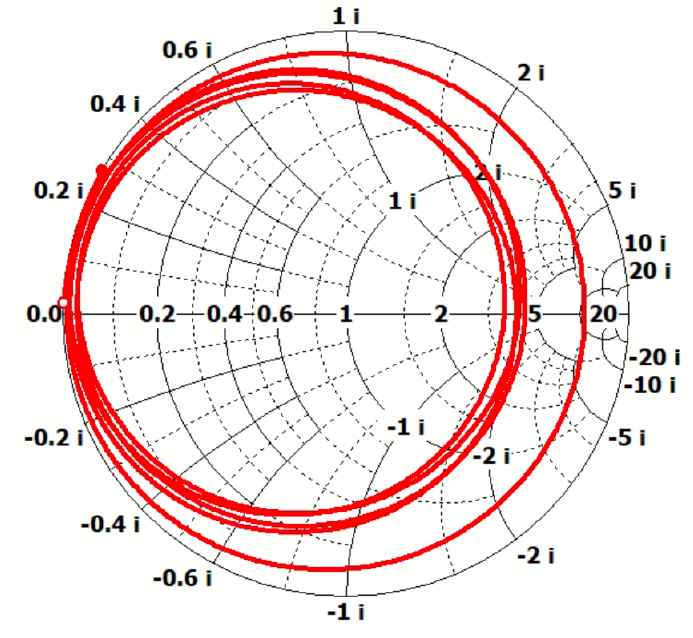
Figure 6. Smith Chart of S11.